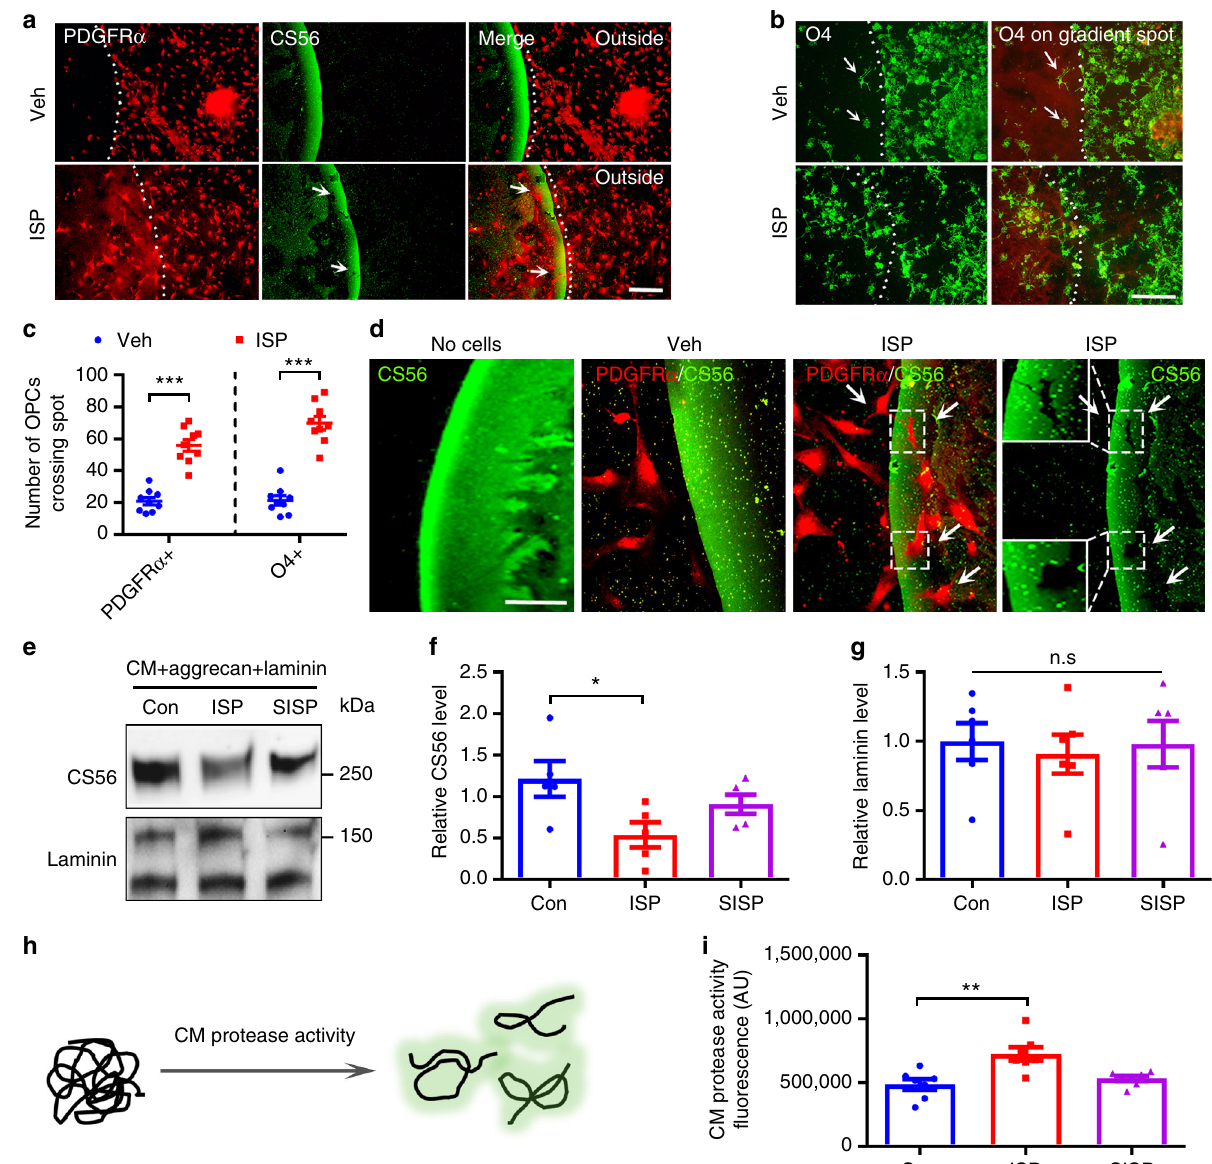
Fig. 5 ISP increases CSPG-degrading protease activity. a , b CSPG gradient crossing assay shows that ISP treatment promotes the crossing of PDGFR α + or O4 + OPCs through the gradient of CSPG. Scale bar = 100 μ m. c Quanti fi cation of immunostaining for the amount of PDGFR α + or O4 + OPCs crossing